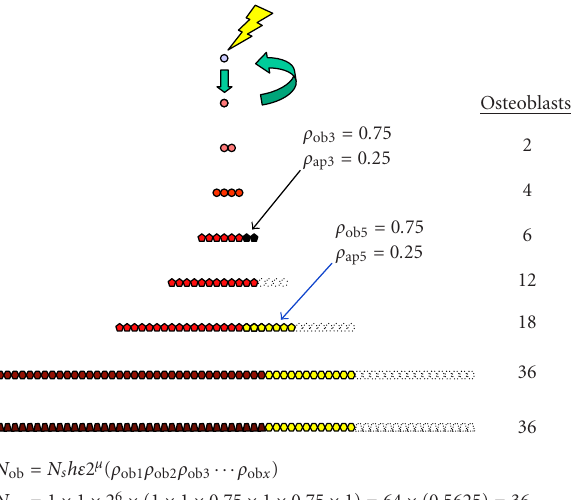
Figure 4. Competing di ff erentiation options and events. The e ff ect of alternative commitment events on the number of mature osteoblasts produced after the activation of one connective tissue stem cell is shown. In this example, the probability of retaining an osteoblastic phenotype ( ρ ob ) was 1 after all mitotic events, with the exception of the third and fifth symmetric mitosis. After the third mitosis, 25% of the cells undergo apoptosis ( ρ ob3 = 0 . 75). As a result, 16 fewer cells are produced. After the fifth mitosis, 25% of the cells commit to adipocytic di ff erentiation ( ρ ob5 = 0 . 75). Twelve adipocytes are the result. These events leave an overall probability of osteoblastic di ff erentiation ( P ob ) among the possible progeny of 0.5625 (0 . 75 × 0 . 75). The result is an approximately 44% reduction in the total number of osteoblasts produced, from 64 to 36. Even if these progenitors continue to proliferate for many more cell divisions before di ff erentiating without further commitment to nonosteoblastic phenotypes, these two events related to the third and fifth mitosis e ff ectively limit the number of mature osteoblasts to only 56% of the theoretical